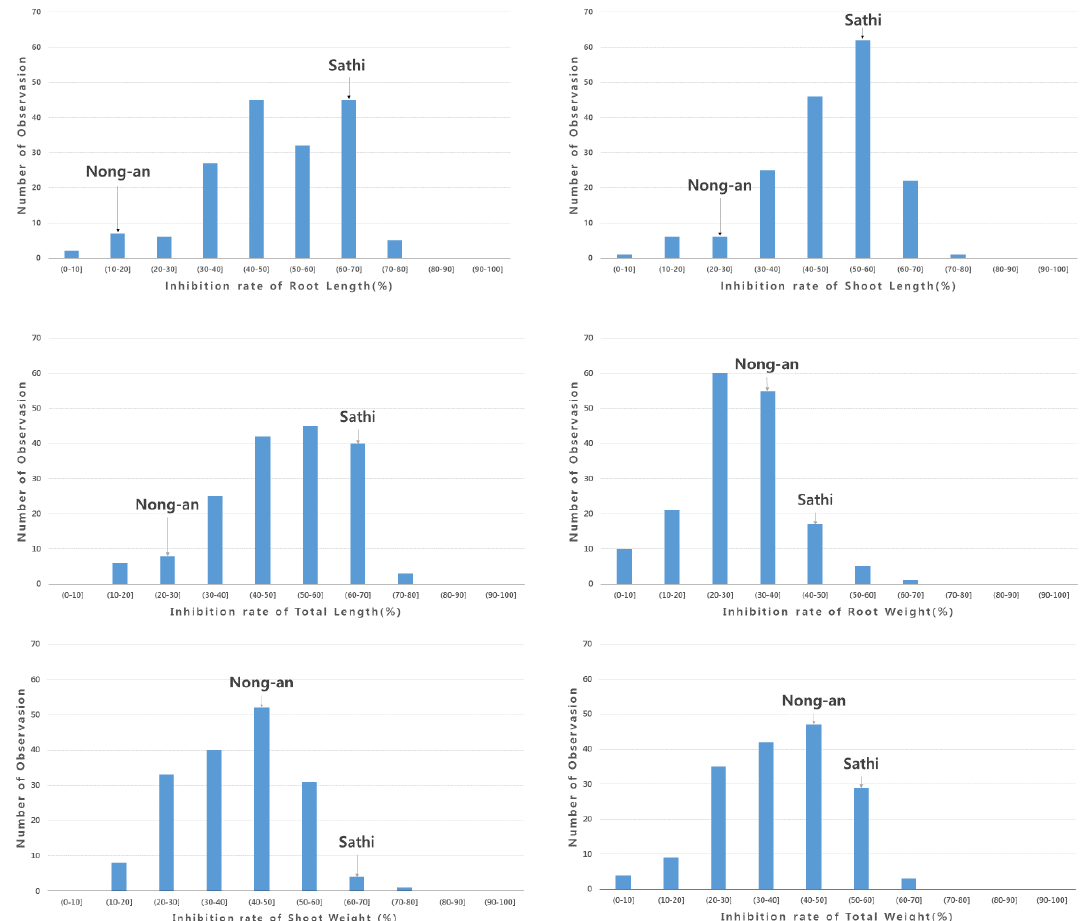
Figure 3. Distribution of growth inhibition rate. ( A ) Inhibition rate of root length, ( B ) inhibition rate of shoot length, ( C ) inhibition rate of total length, ( D ) inhibition rate of root weight, ( E ) inhibition rate of shoot weight, and ( F ) inhibition rate of total weight.